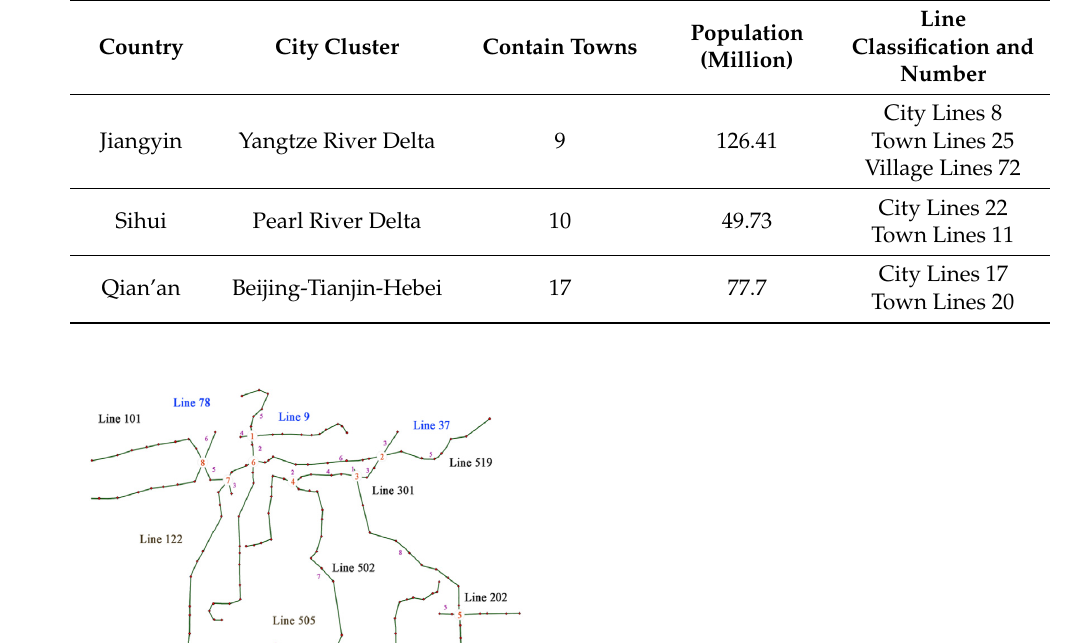
Table 3. Basic features of cases.